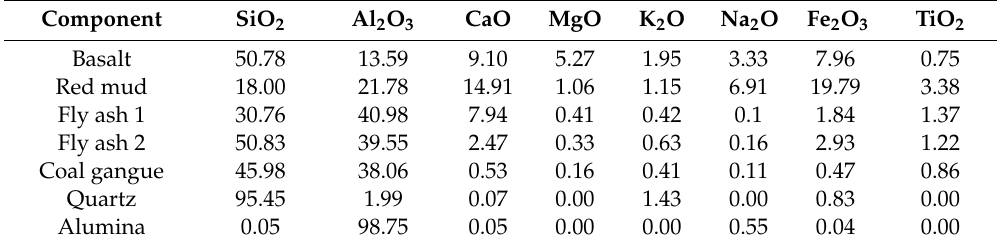
Table 4. The chemical compositions of imitation basalt compounds (wt.%).